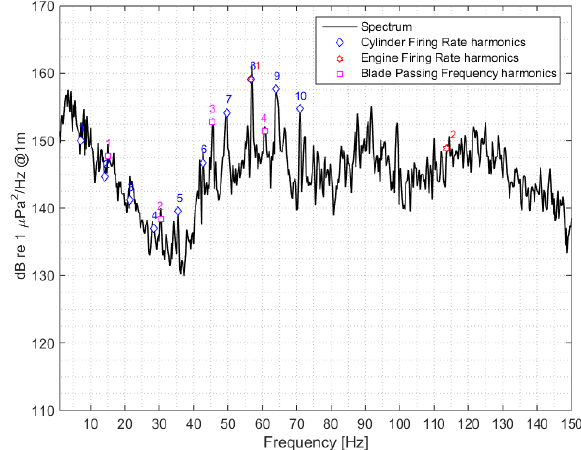
Figure 22: Enlargement of Figure 21 in the band 1–140 Hz with en- gine and propeller tonal components